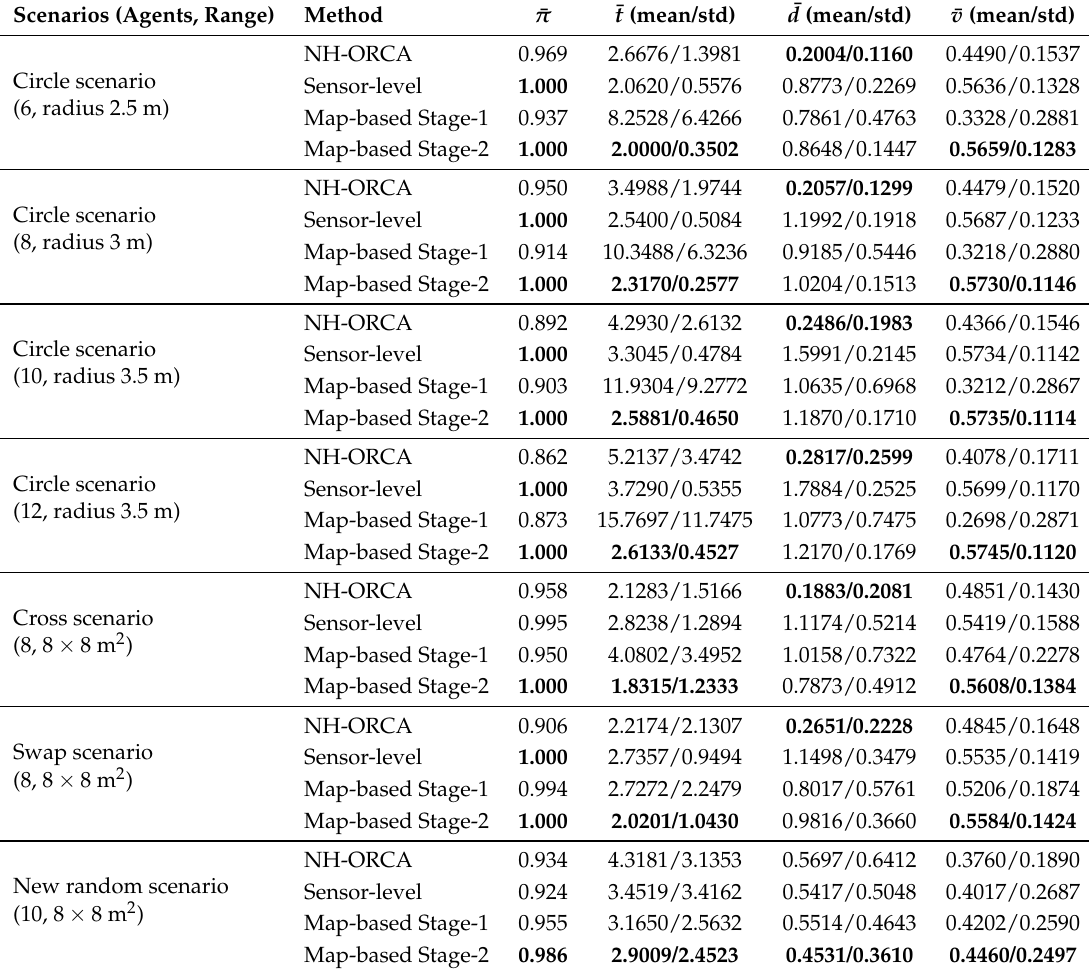
Table 3. Performance metrics (as mean/standard deviation) evaluated for different methods on different scenarios with varied scene sizes and a different number of